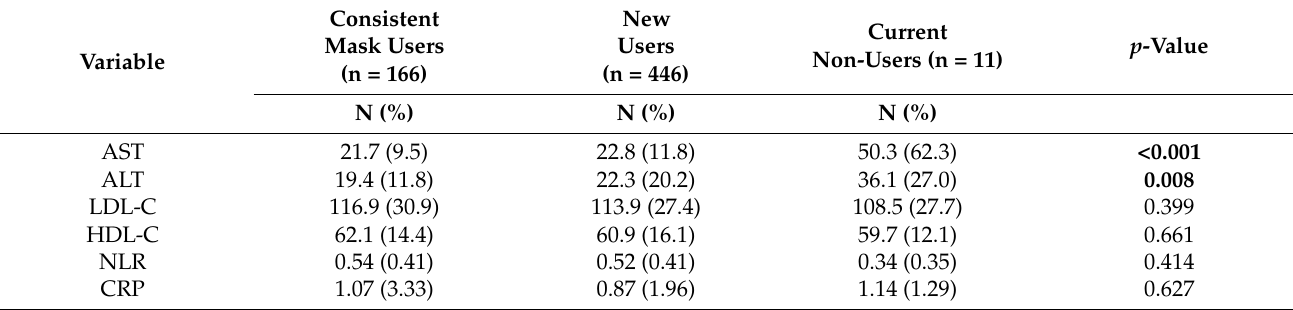
Table 7. The health characteristics as determined by blood sampling by mask use behavior (n = 623) a